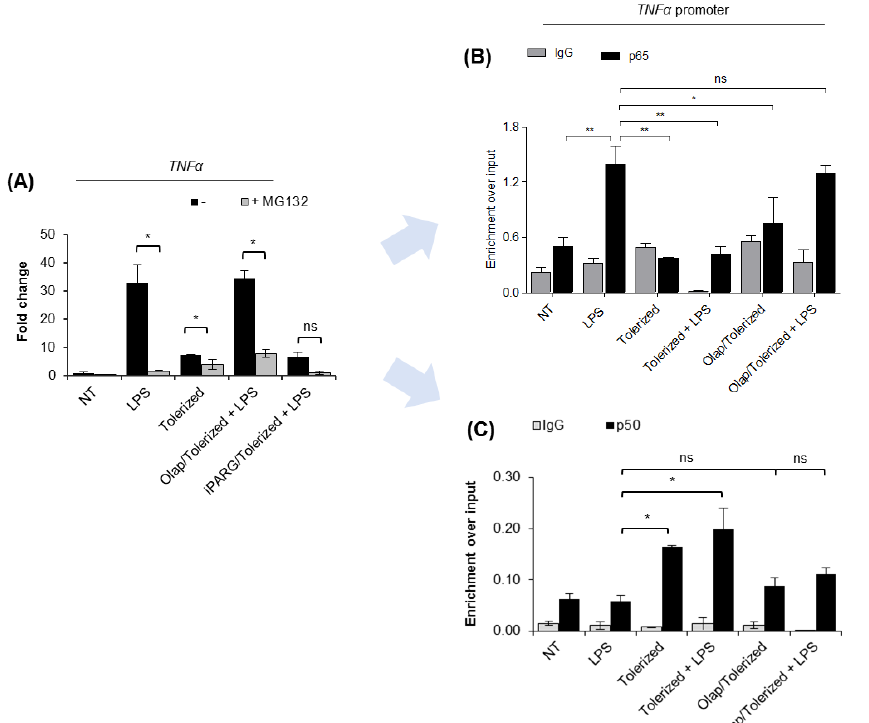
Figure 3. PARP1 eviction from the TNF- α promoter prevents p65 re-binding after LPS re-stimulation. ( A ) The contribution of canonical NF- κ B to macrophage response to LPS was estimated by comparing TNF- α transcription in control and cells pre-treated with proteasome inhibitor (MG132; 1 µ M). mRNA level of the cytokine was quantified by real-time PCR, normalized to median of ACTB and GAPDH and presented as a fold change with respect to untreated cells. ( B ) p65 and ( C ) p50 occurrence at the TNF- α promoter was analyzed by ChIP-real-time PCR. Bars in the figures represent mean ± standard error of the mean (SEM). One-way analysis of variance (ANOVA1) was carried out in GraphPad Prism 5 to compare means in several groups. Once the significance was detected, ANOVA1 was followed by the Tukey post-hoc test and significant differences between the two considered means are marked with * when significant at p < 0.05, ** when significant at p < 0.01, ns—non-significant at p > 0.05. Abbreviations: LPS—lipopolysaccharide, Olap—olaparib,